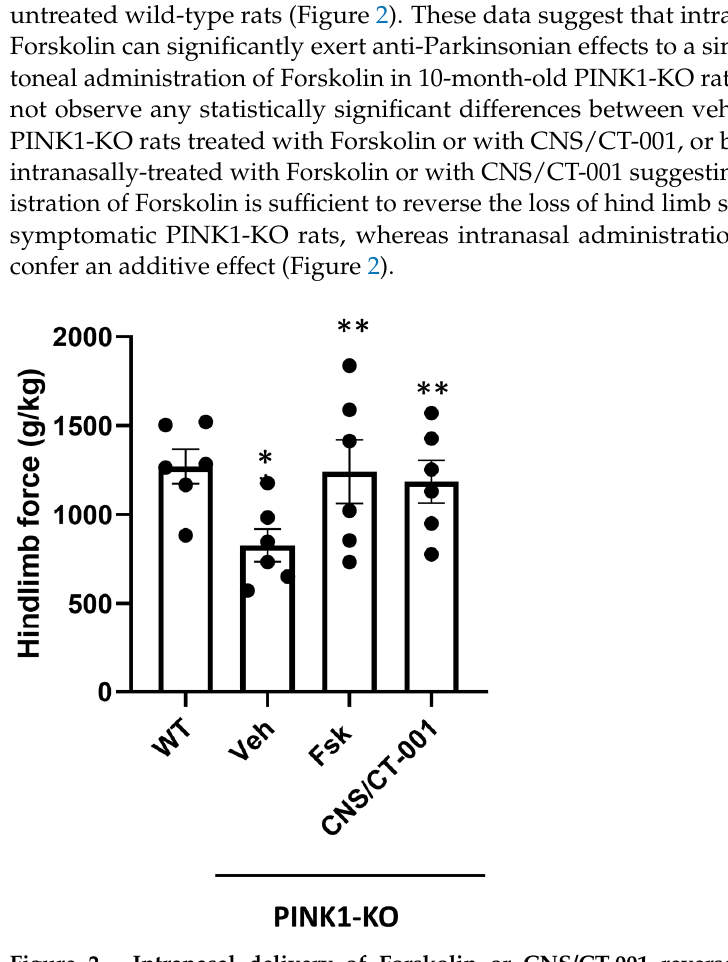
Figure 2. Intranasal delivery of Forskolin or CNS/CT ‐ 001 reverses muscle fatigue in the hindlimbs of PINK1 ‐ KO rats . Compiled quantification of grip strength in the hind limbs in WT and PINK1 KO rats that were left untreated (basal) or intranasally treated with vehicle (Veh) control, Forskolin (Fsk), or with CNS/CT ‐ 001 (10 days for five doses). The data are expressed as grams of reversed the reduction in hind limb strength in PINK1-KO rats and significantly augmented muscle force per kg. The data show that either intranasal administration of Forskolin or CNS/CT ‐ 001 sig ‐ strength to a similar extent as in untreated or vehicle-treated WT rats. Mean ± SEM. *: p ≤ nificantly reversed the reduction in hind limb strength in PINK1 ‐ KO rats and significantly aug ‐ mented muscle strength to a similar extent as in untreated or vehicle ‐ treated WT rats. Mean ± SEM. *: p ≤ 0.05, Kruskal ‐ Wallis test with Bonferroni correction, n = 8–11 animals per group, *: p < 0.05 vs. WT group; **: p < 0.05 vs. PINK1 ‐ KO/Veh group. Each circle indicates an individual animal plotted in the graph.